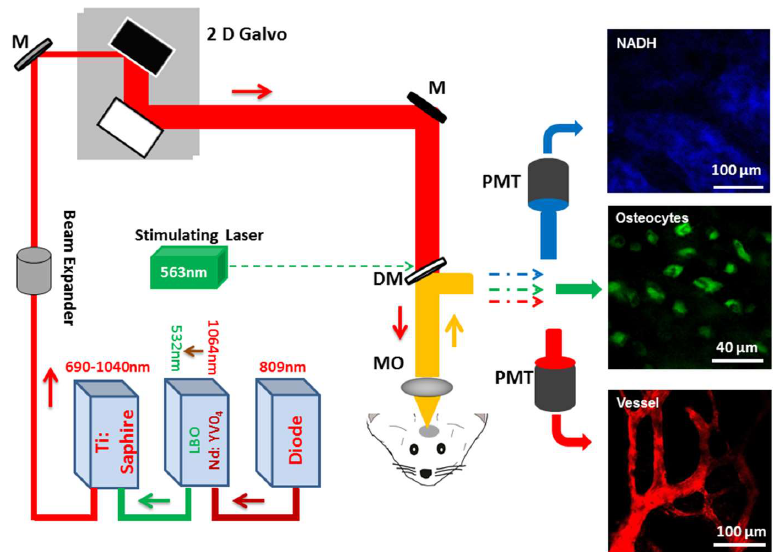
Figure 1. Schematic illustration of two photon imaging system. Abbrv: M, mirror; DC, dichroic mirror; MO, microscope objective; PMT, photomultiplier tube; 2D Galvo, two dimension